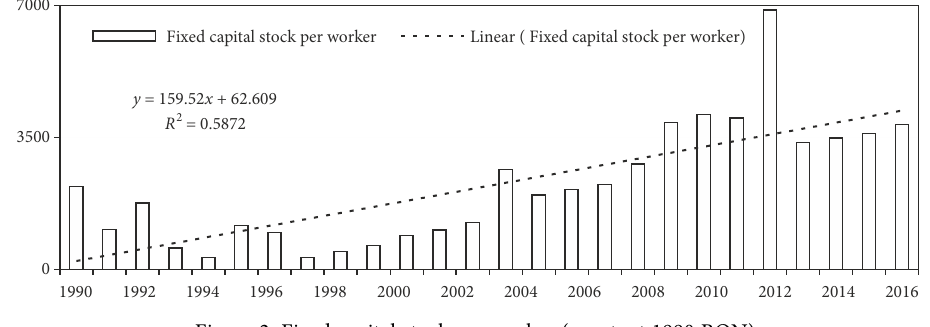
Figure 2. Fixed capital stock per worker (constant 1990 RON) (Data sources: WBD, ILO, NIS, and authors’ processing)